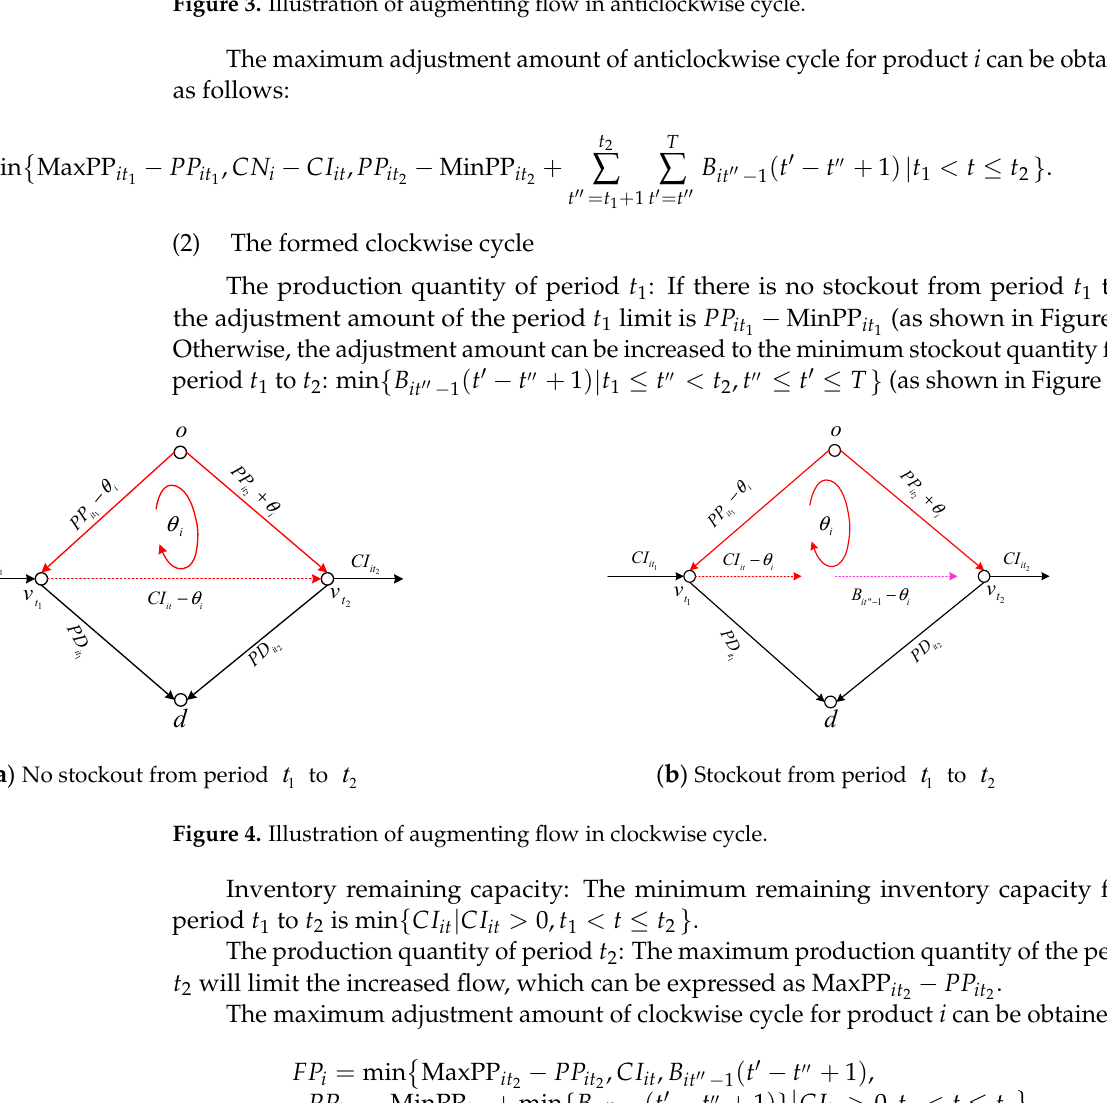
Figure 3. Illustration of augmenting flow in anticlockwise cycle.